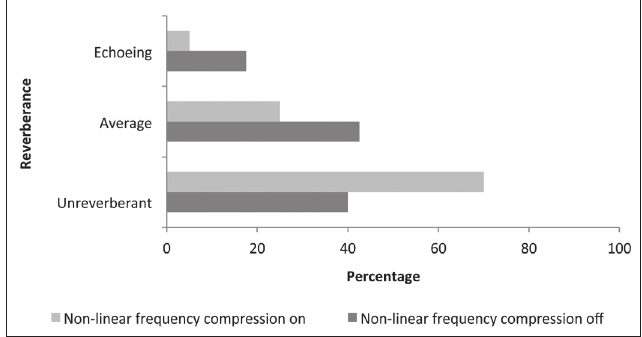
Fig. 8. Participants’ perception of the reverberance of music with NFC off versus NFC on.